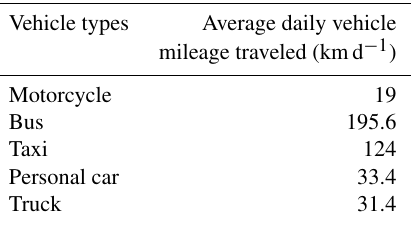
Table 5. The emission factors (gkm − 1 per vehicle) from literature